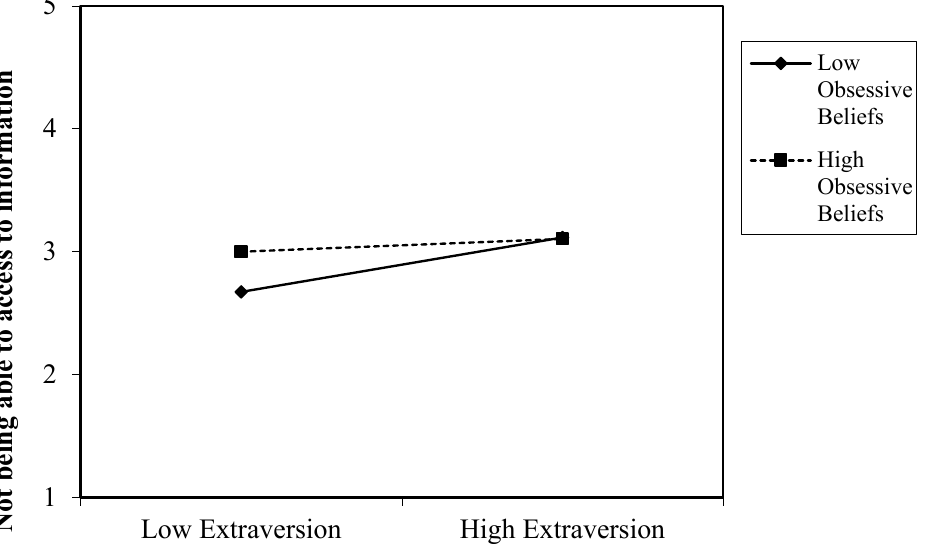
Figure 1. Interaction of extraversion and obsessive beliefs in predicting fear of not being able to access information.